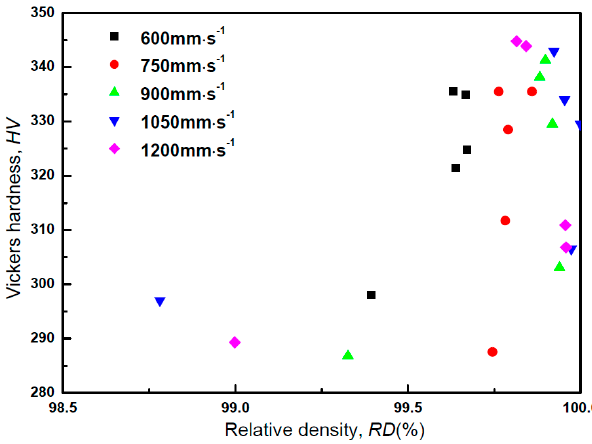
Figure 14. Vickers hardness of the as-built Zr-1Mo alloys as a function of relative density (RD).